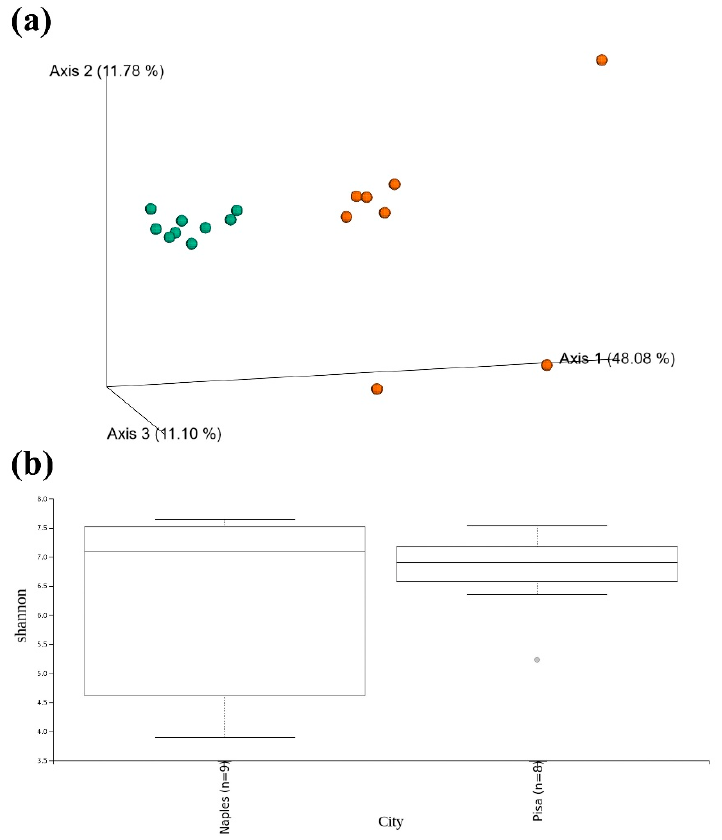
Figure 2. Diversity measures calculated on 16S rRNA gene sequencing data. ( a ) Beta diversity represented by Principle Coordinate Analysis Emperor plot on a Bray–Curtis distance matrix. Green dots: Naples, orange dots: Pisa. ( b ) Boxplots of Alpha-diversity Index (calculated as Shannon index) in the two archaeological sites.